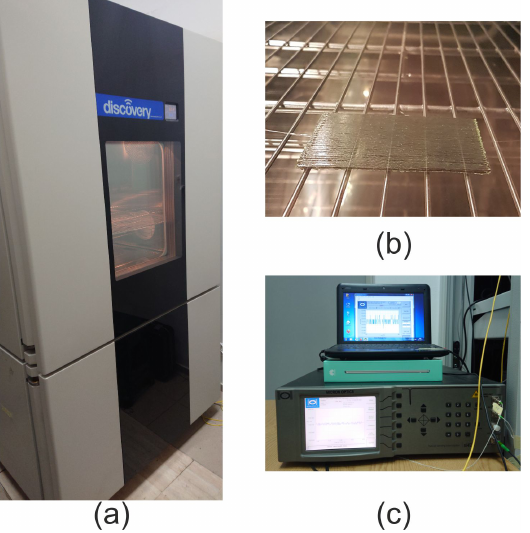
Figure 1. Measurement set-up: ( a ) Environmental chamber, ( b ) sample placed on a shelf inside the chamber, ( c ) interrogator with the